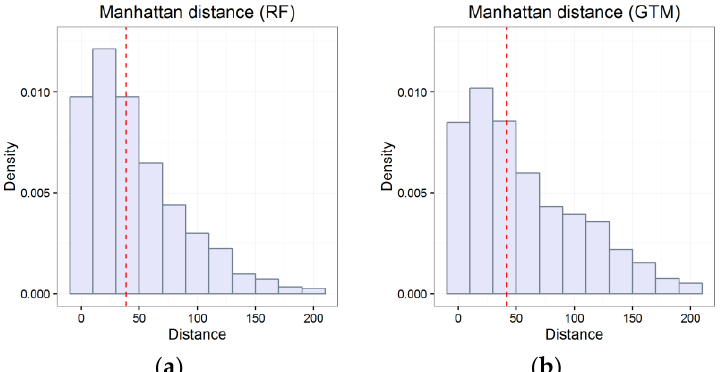
Figure 8. Histograms of the Manhattan distance between real and model «forest stand formulas»: ( a ) RF model; ( b ) GTM model.